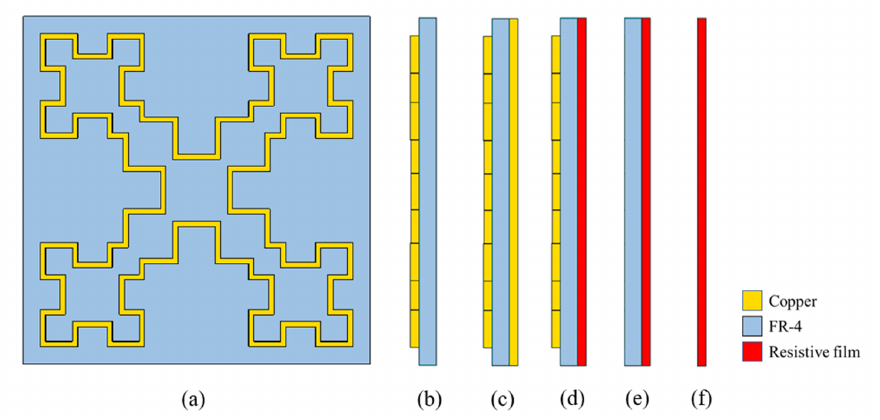
Figure 6. The schematic of ( a ) the Minkowski fractal structure. ( b ) Case I: without the back plane. ( c ) Case II: with the copper film. ( d ) Case III: the proposed MMA unit cell with resistive film. ( e ) Case IV: without the fractual structure. ( f ) Case V: only the resistive